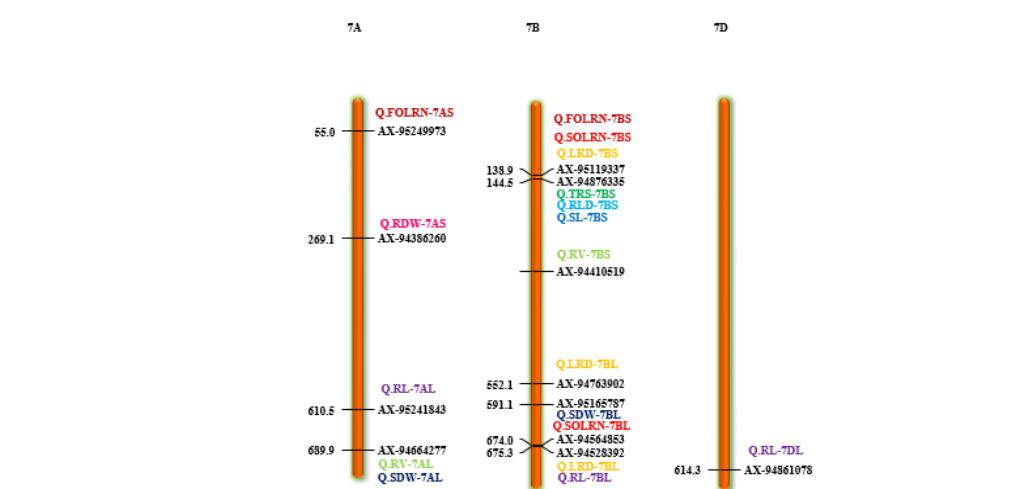
Figure 4. Chromosome location of 87 reliable QTNs (quantitative trait nucleotides) for 15 root and shoot traits. The color bars represent QTNs identified for different traits, red = SOLRN (second order lateral root number); dark green = TRS; (total root size) light green = RV (root volume); orange = AD (average diameter); pink = RDW (root dry weight); light blue = RLD (root length density); blue = SL (shoot length). (For interpretation of color references in this figure legend, refer to the web version of this article).